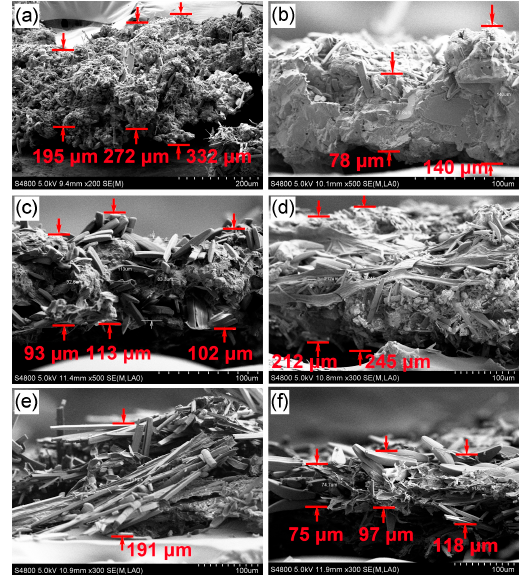
Figure 4. Deposit thickness under SEM at studied site s in one-year period. ( a ) Porous tufa deposits with uneven thicknesses (195 to 332 µ m/y), S PL ; ( b ) Compacted and clotted deposits (78